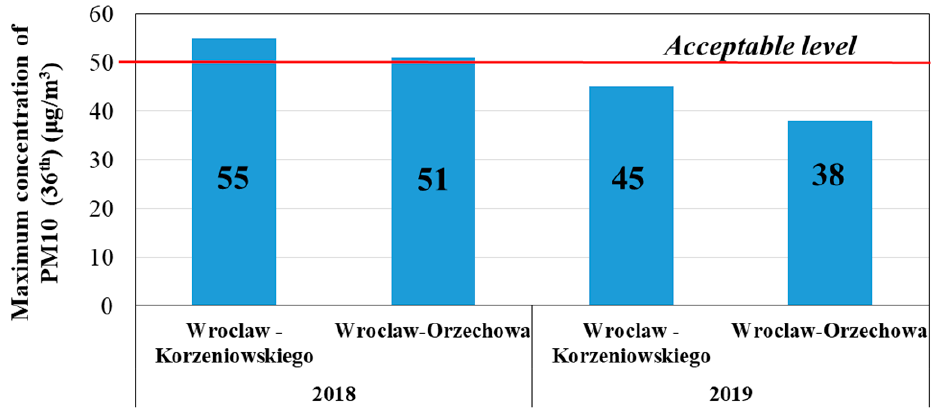
Figure 5. Maximum concentration of PM10 (36th) in Wroclaw [31,32].